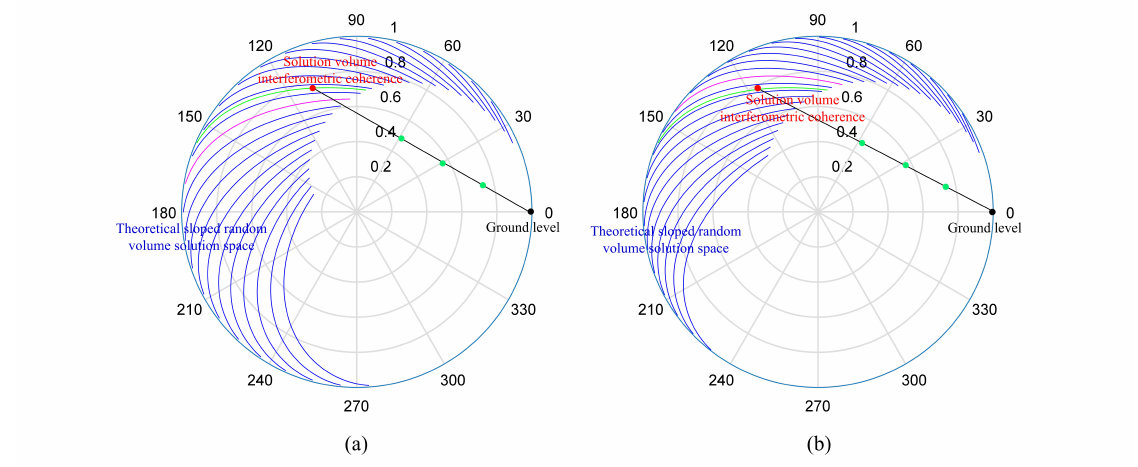
Figure 4. The schematic representation of the S-RVoG model: ( a ) The positive terrain slope (5 deg) and ( b ) the negative terrain slope ( − 5 deg). The parameter setting of the theoretical sloped random volume coherence is consistent with Figure 2. The green and pink curves represent the volume coherences corresponding to a 19-m forest height based on the RVoG and S-RVoG models, respectively. The green dots denote the coherence